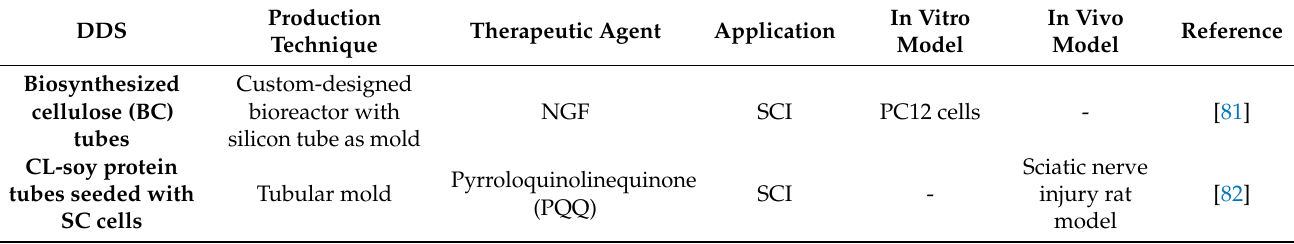
Table 5. Summary of CL-based DDSs for SCI. DDS description, production technique, therapeutic agent delivered, and in vitro and in vivo models exploited for efficacy assessment are